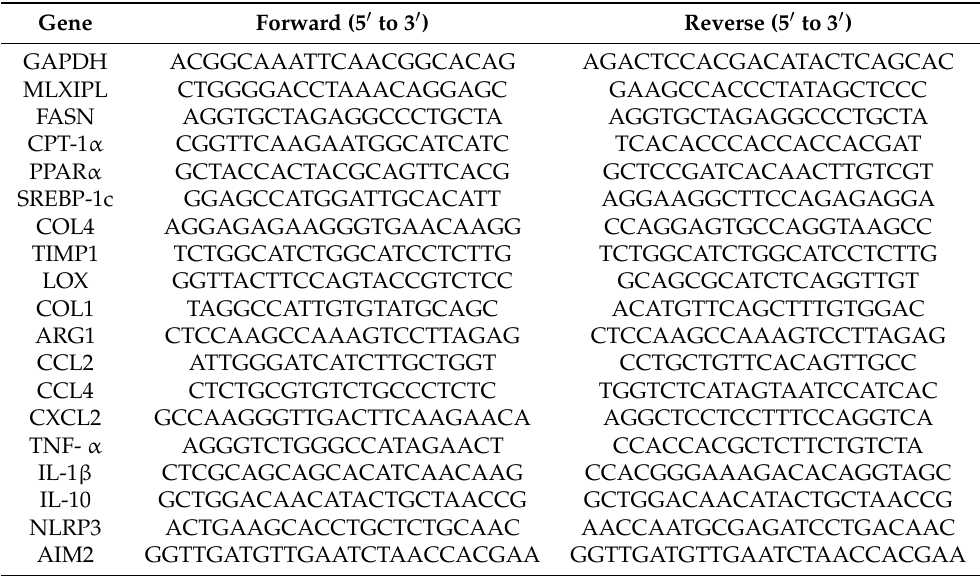
Table 2. Primer sequences of the genes used for quantitative real-time polymerase chain reaction. Gene Forward (5 (cid:48) to 3 (cid:48) ) Reverse (5 (cid:48) to 3 (cid:48)